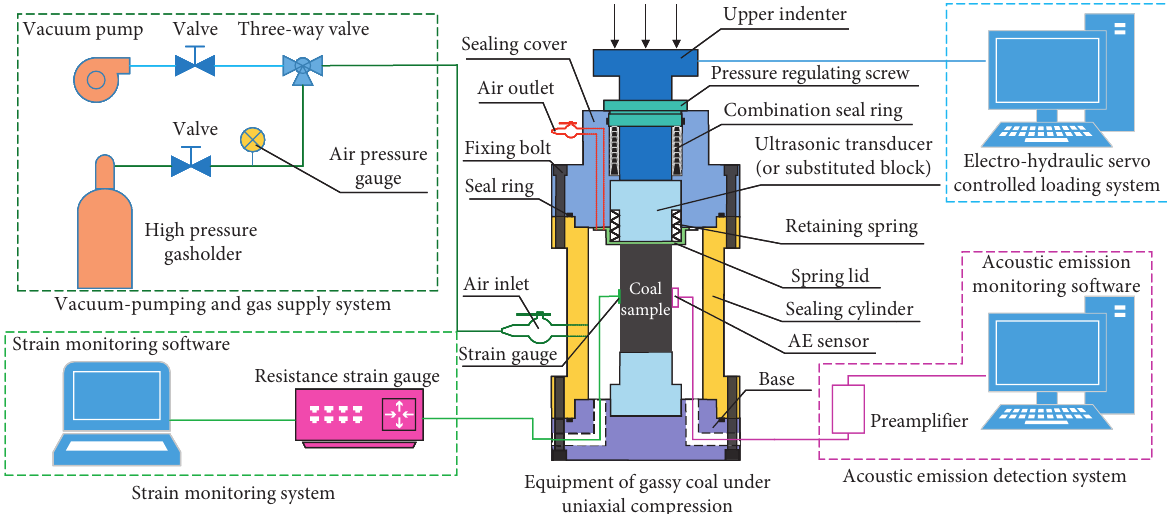
Figure 5: Schematic of the experiment system for the gas-containing coal under uniaxial compression